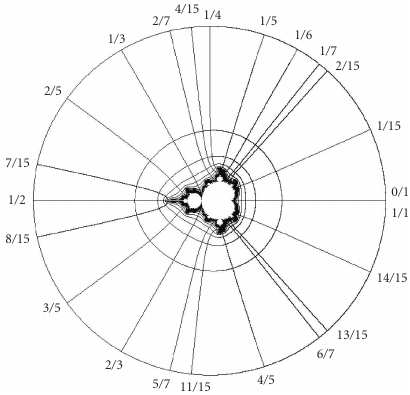
Figure 1.1 . Mandelbrot set with some equipotential lines, external rays, and external